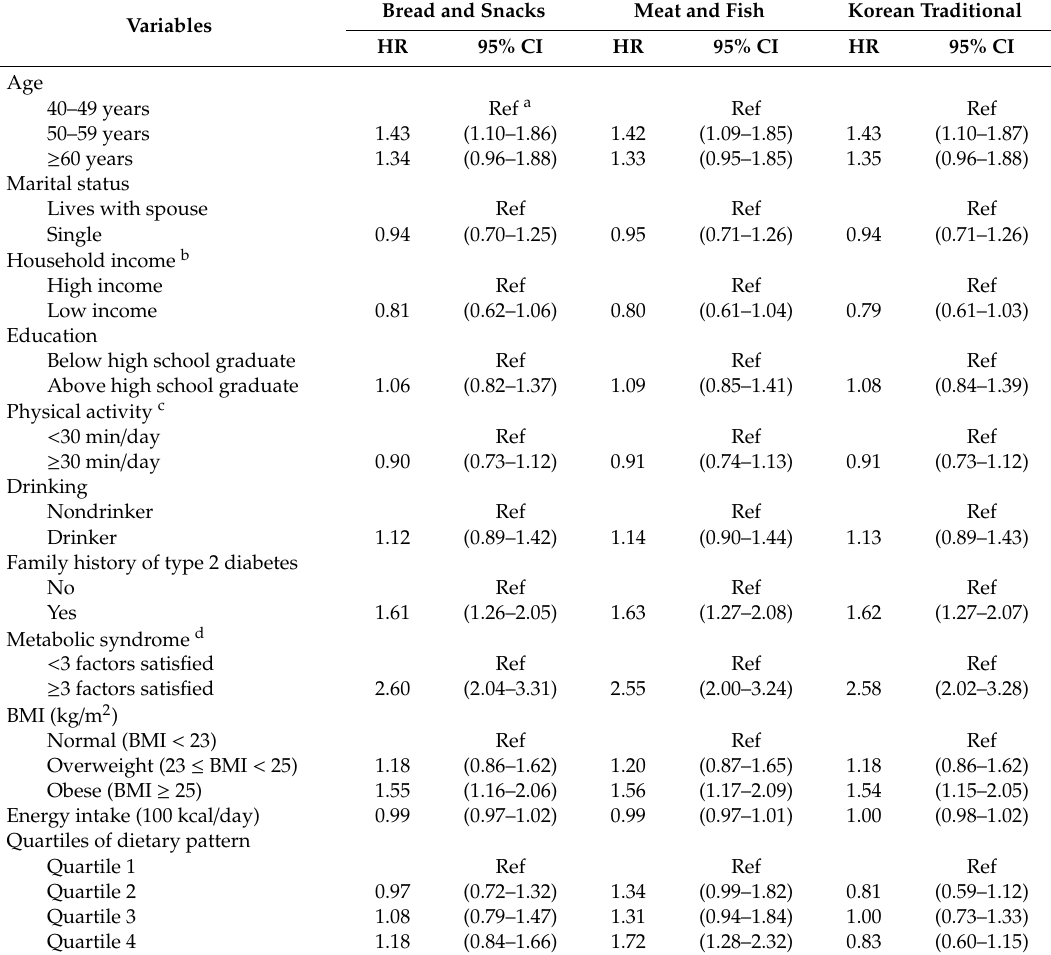
Table 3. Hazard ratios (HRs) and 95% confidence intervals (CIs) for type 2 diabetes from multivariable Cox regression in female